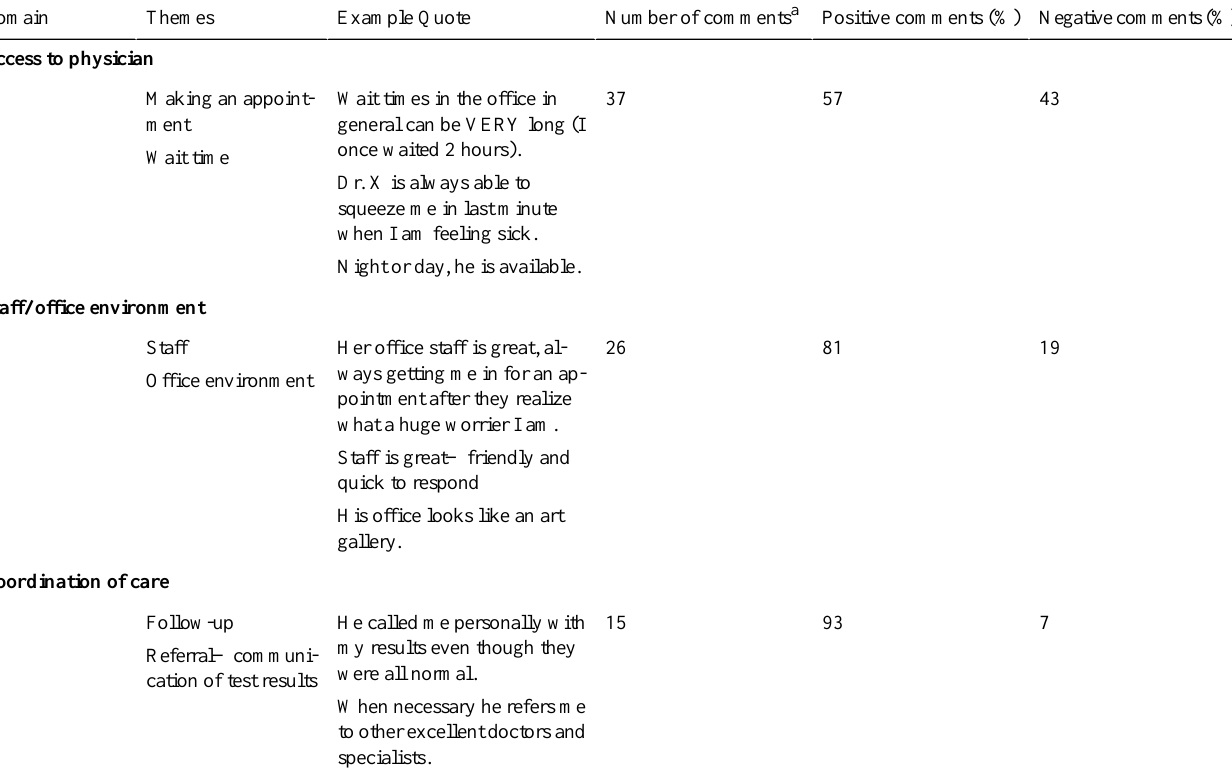
Table 2. Themes in